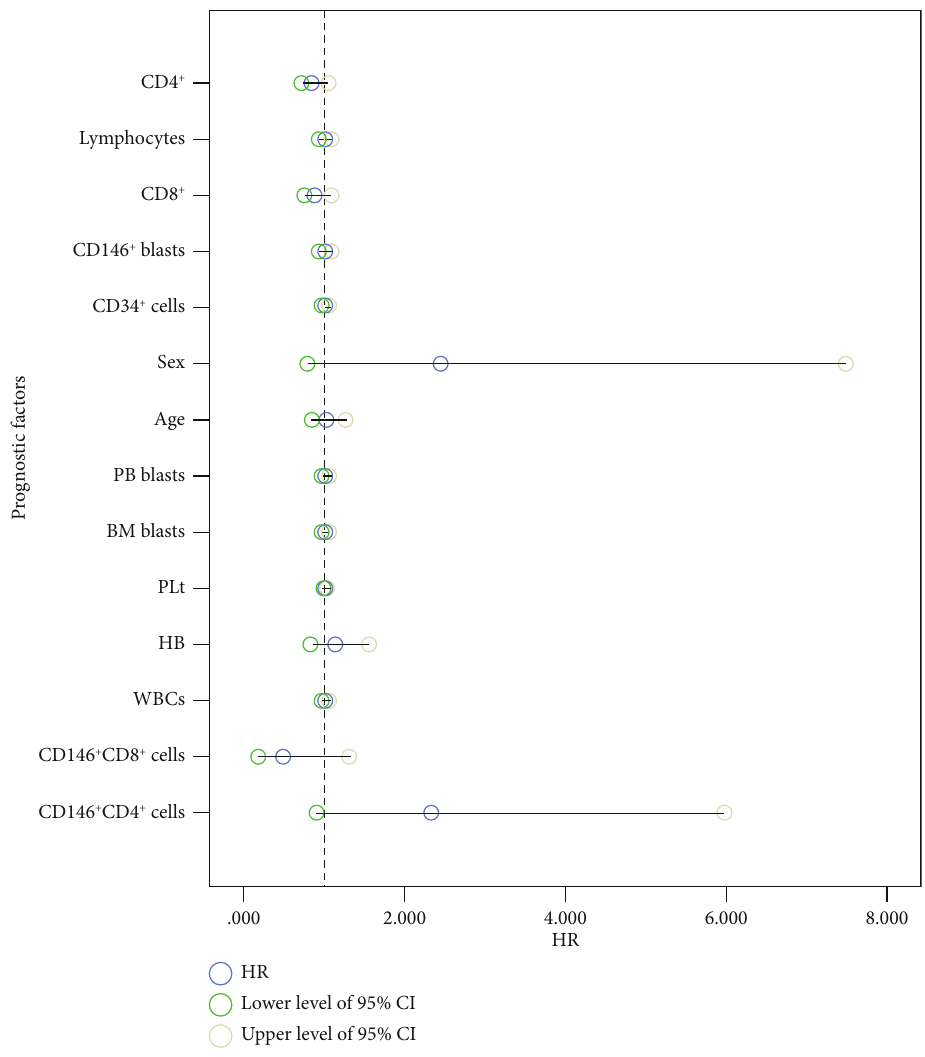
Figure 9: Forest plot of di ff erent prognostic factors of